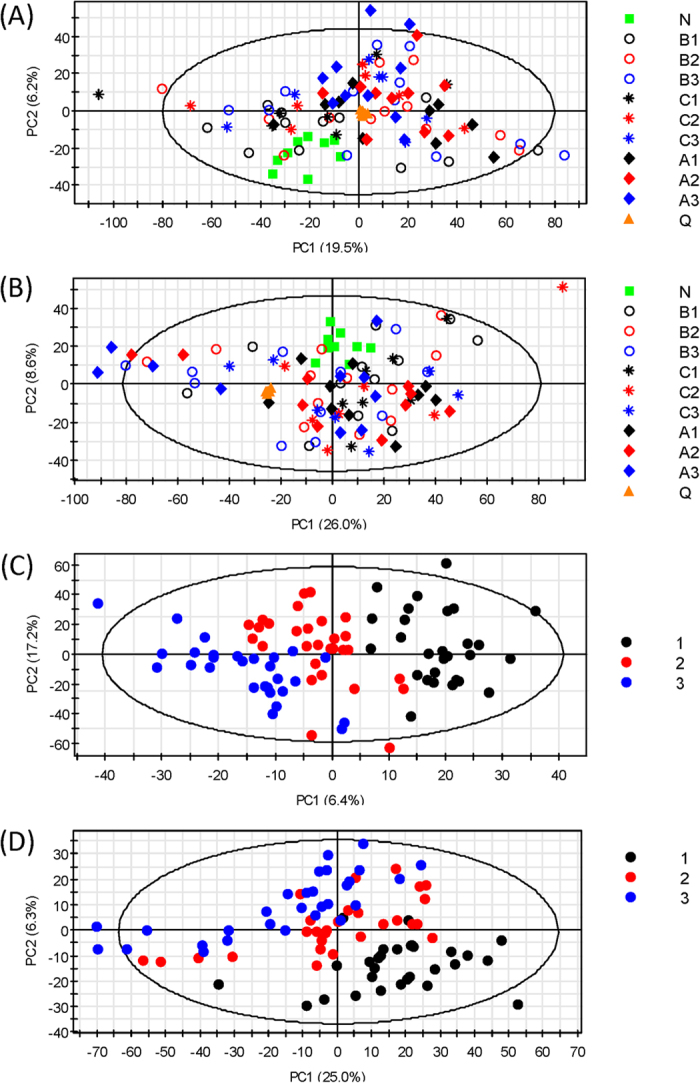
PCA score plots for (A) serum and (B) CSF. Green box: non-injured control; black: t1; red: t2; blue: t3; diamond: AIS A; circle: AIS B; star: AIS C; orange triangle: quality control. PLS-DA score plots for (C) serum and (D) CSF. Black: t1; red: t2; blue: t3. The PLS-DA model was cross-validated using twenty permutation tests.